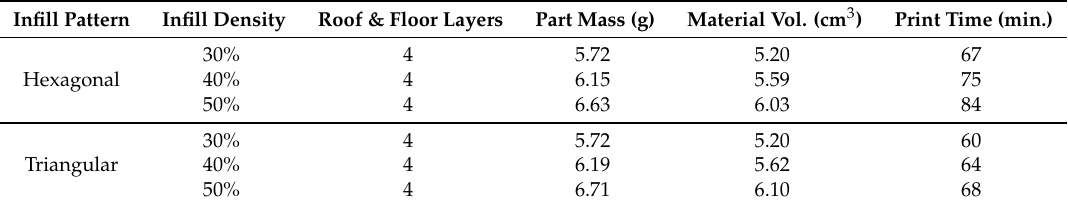
Table 2. Nylon substrates information from Eiger for Research Question 2.